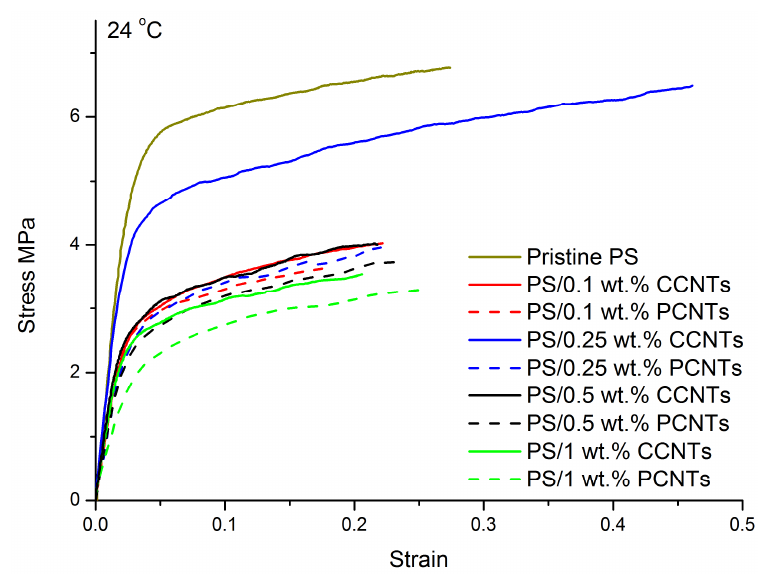
Figure 5. Engineering stress–strain curves of PS nanocomposite membranes with different contents of CCNTs or PCNTs at room temperature and at an initial strain rate of 0.17/s.